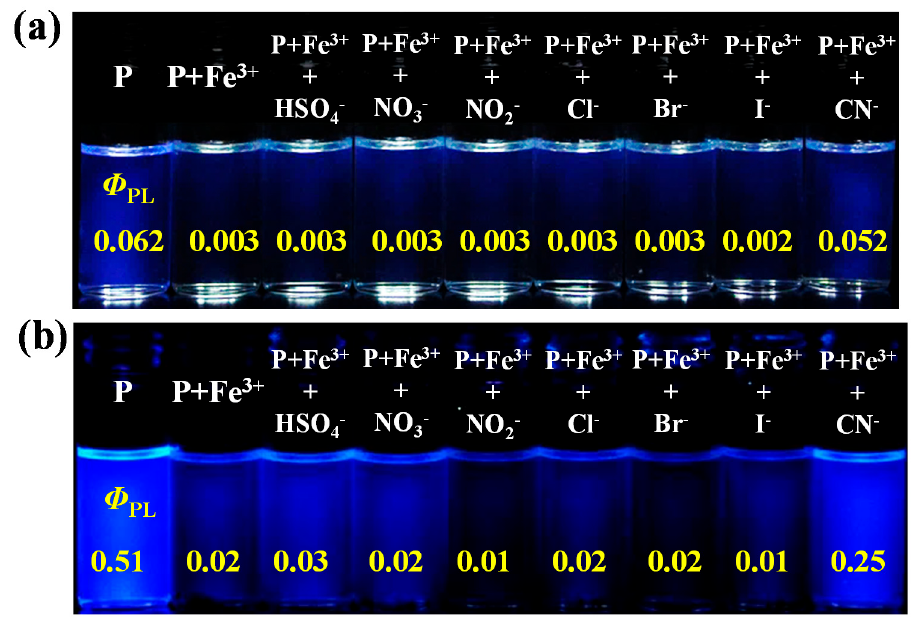
Figure 7. Fluorescence colors of ( a ) PCaT ‒ Fe 3+ and ( b ) PCT ‒ Fe 3+ solutions after the addition of various anions. The values in images are their corresponding quantum yields ( Φ PL s) after adding the given anions.